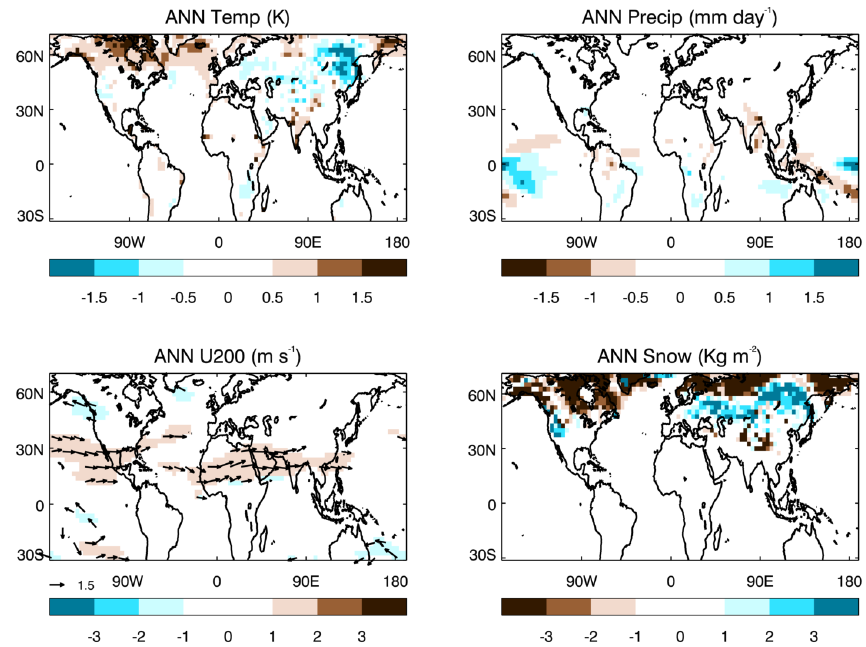
Fig. 3. Regional differences between TRIF and WHS for annual means of (upper left) temperature, (upper right panel) precipitation, (lower left panel) 200hPa zonal wind, and (lower right panel) snow cover. The wind vector anomalies are also included in the U200